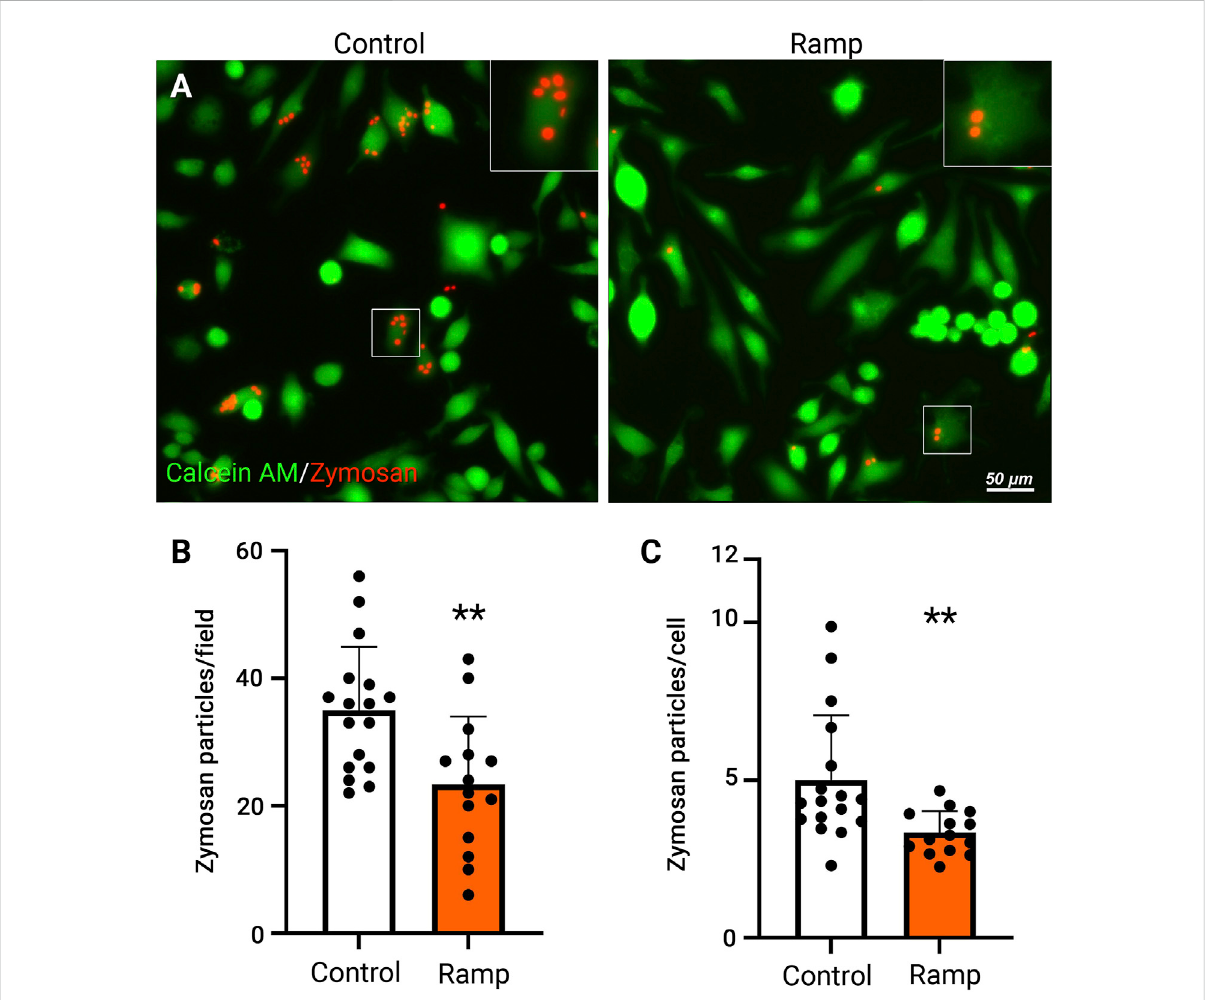
FIGURE 3 RampESreducesphagocytosisofBV-2cells.Representative fl uorescentimagesofBV-2cellsculturedunderacontrolconditionorESbiphasic ramp (A) and incubated with fl uorescent (cy3) zymosan particles (red) for 24 h and Calcein AM stain (green) was used to visualize BV-2 cells. Scale bar: 50 µm. Inserts present individual cells with zymosan particles. Quanti fi cation of zymosan particles in BV-2 cells in control and ramp ES-treated cultures per fi eld (B) and the average number of zymosan particles per cell (C) ; Control n = 17; Ramp n = 14. Statistical signi fi cance was determined by Student ’ s t-test. ** p < 0.01; value = means ±